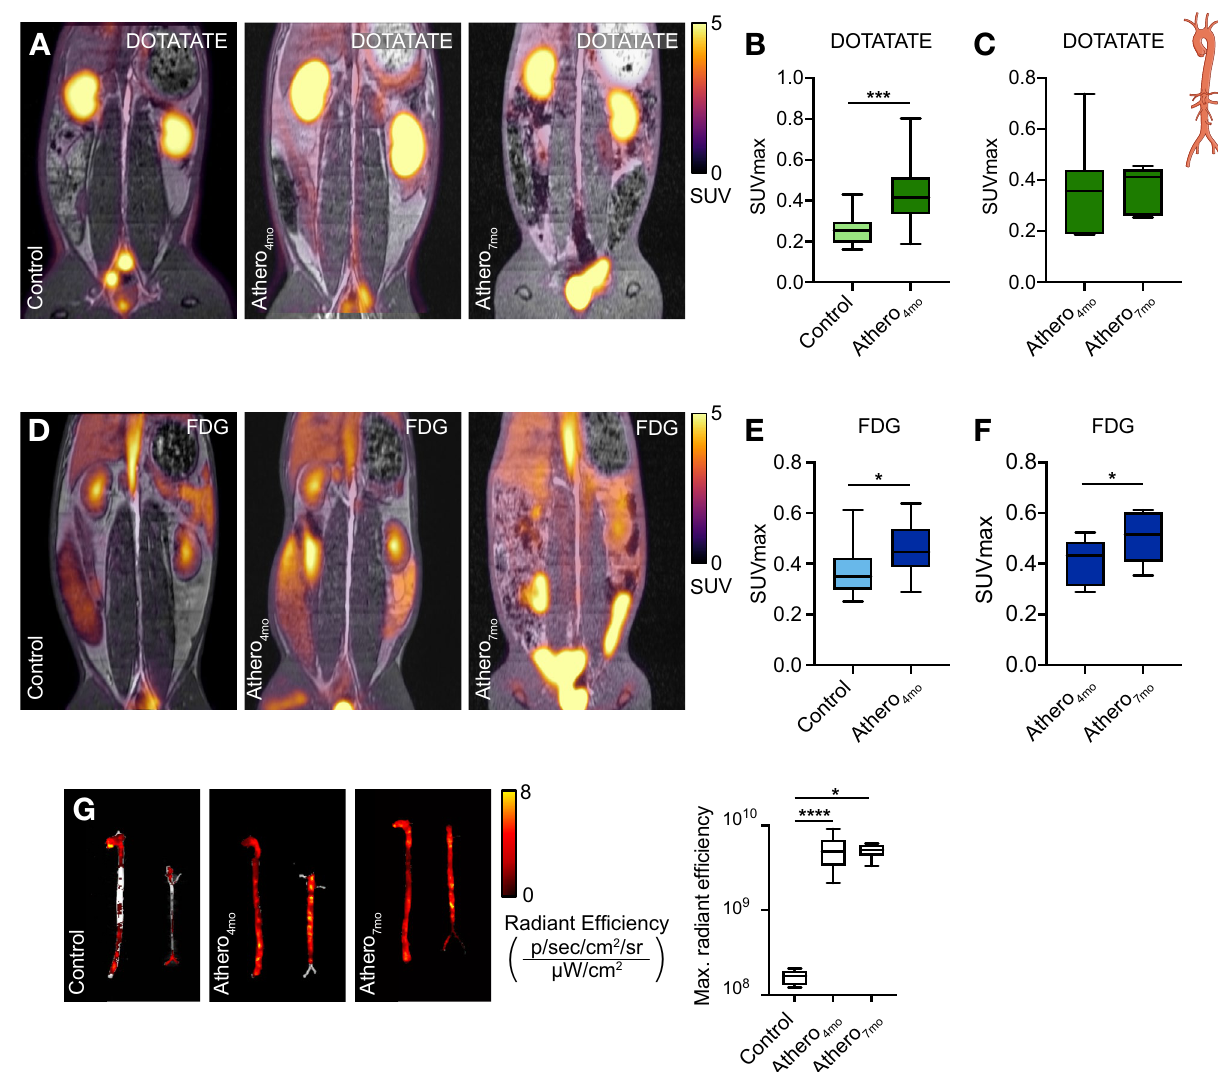
Figure 6. In vivo and ex vivo imaging of atherosclerosis in rabbits. ( A ) Representative fused PET/MR image of [ 68 Ga]Ga-DOTATATE-infused control (left), athero 4mo (middle) and athero 7mo (right) rabbits. ( B ) [ 68 Ga] Ga-DOTATATE SUV max of abdominal aorta in control and athero 4mo animals. Controls N = 10 and athero 4mo N = 32. ( C ) Paired analysis of [ 68 Ga]Ga-DOTATATE SUV max of abdominal aorta in athero 4mo and athero 7mo animals. N = 7 per group. ( D ) Representative fused PET/MR image of [ 18 F]F-FDG-infused control (left), athero 4mo (middle) and athero 7mo (right) rabbits. ( E ) [ 18 F]F-FDG SUV max of abdominal aorta in control and athero 4mo animals. controls N = 11 and athero 4mo N = 27. ( F ) Paired analysis of [ 18 F]F-FDG SUV max of abdominal aorta in athero 4mo and athero 7mo animals. N = 7 per group. ( G ) Near-infrared fluorescence imaging of Cy5.5- HDL in the aorta of rabbits. Controls N = 11, athero 4mo N = 15 and athero 7mo N = 8. DOTATATE: [ 64 Cu] Cu-DOTATATE; FDG: [ 18 F]F-FDG; SUV max : maximum standardized uptake value. * p < 0.05, *** p < 0.001, **** p < 0.0001. Data are presented as median (interquartile